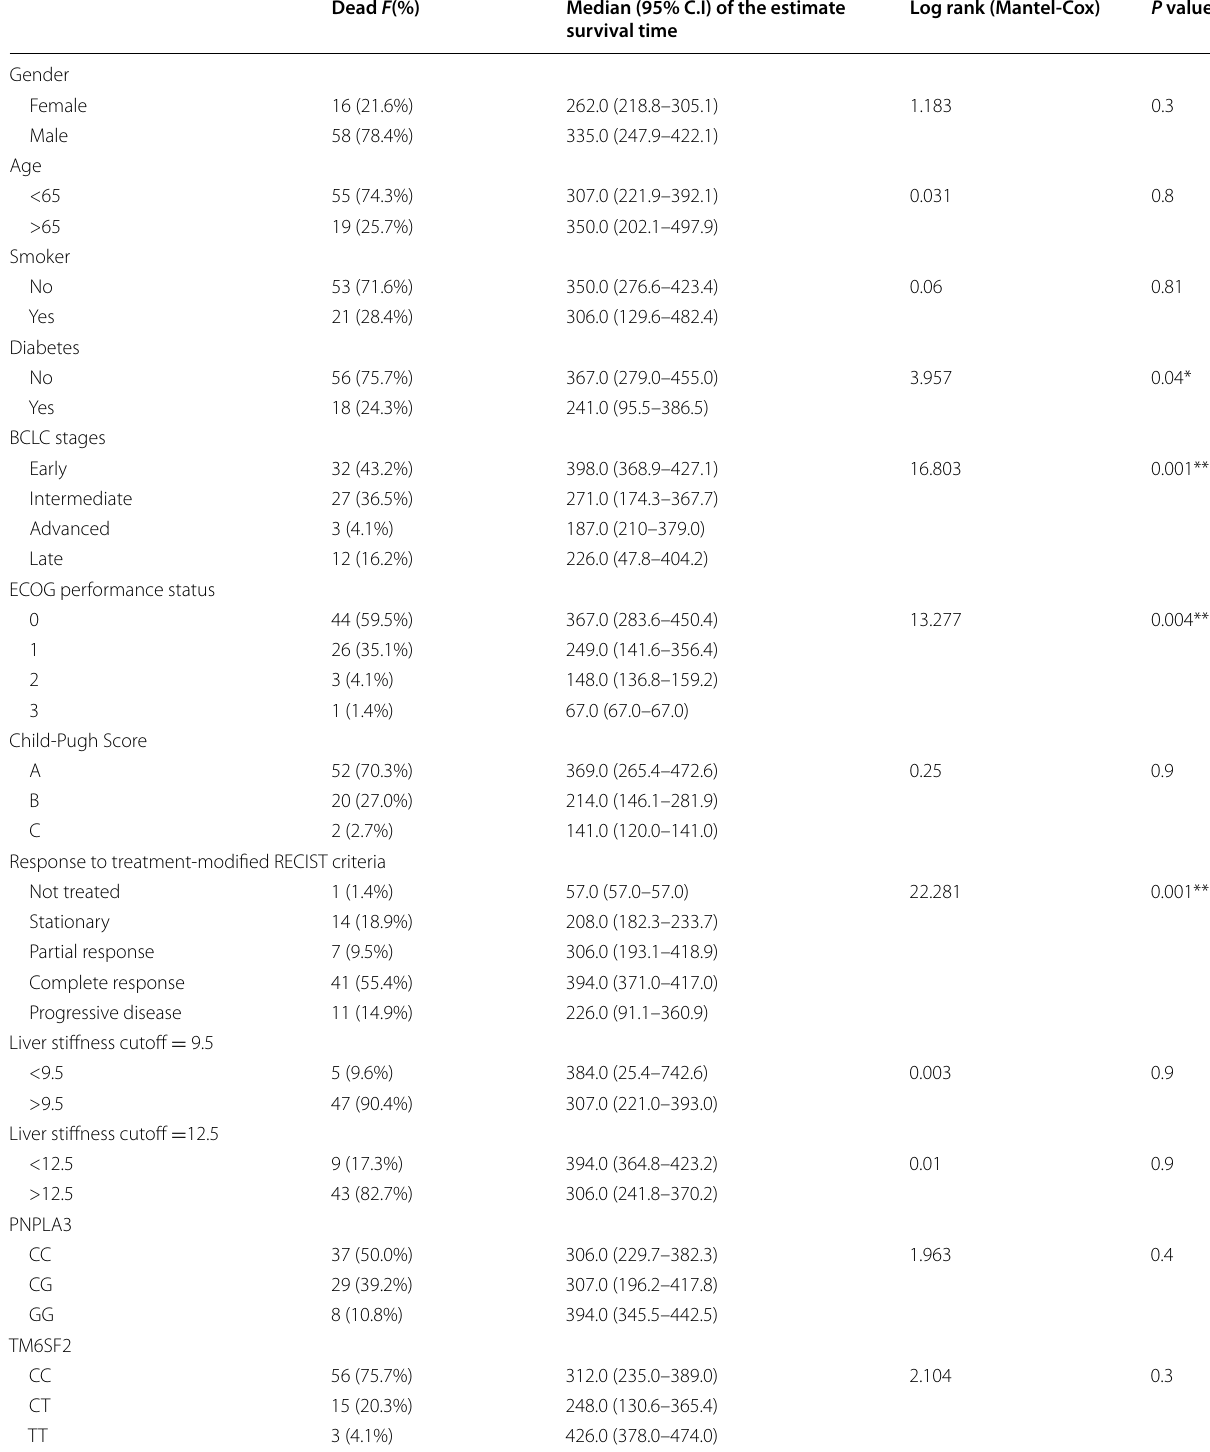
Table 6 Factors associated with survival in HCC